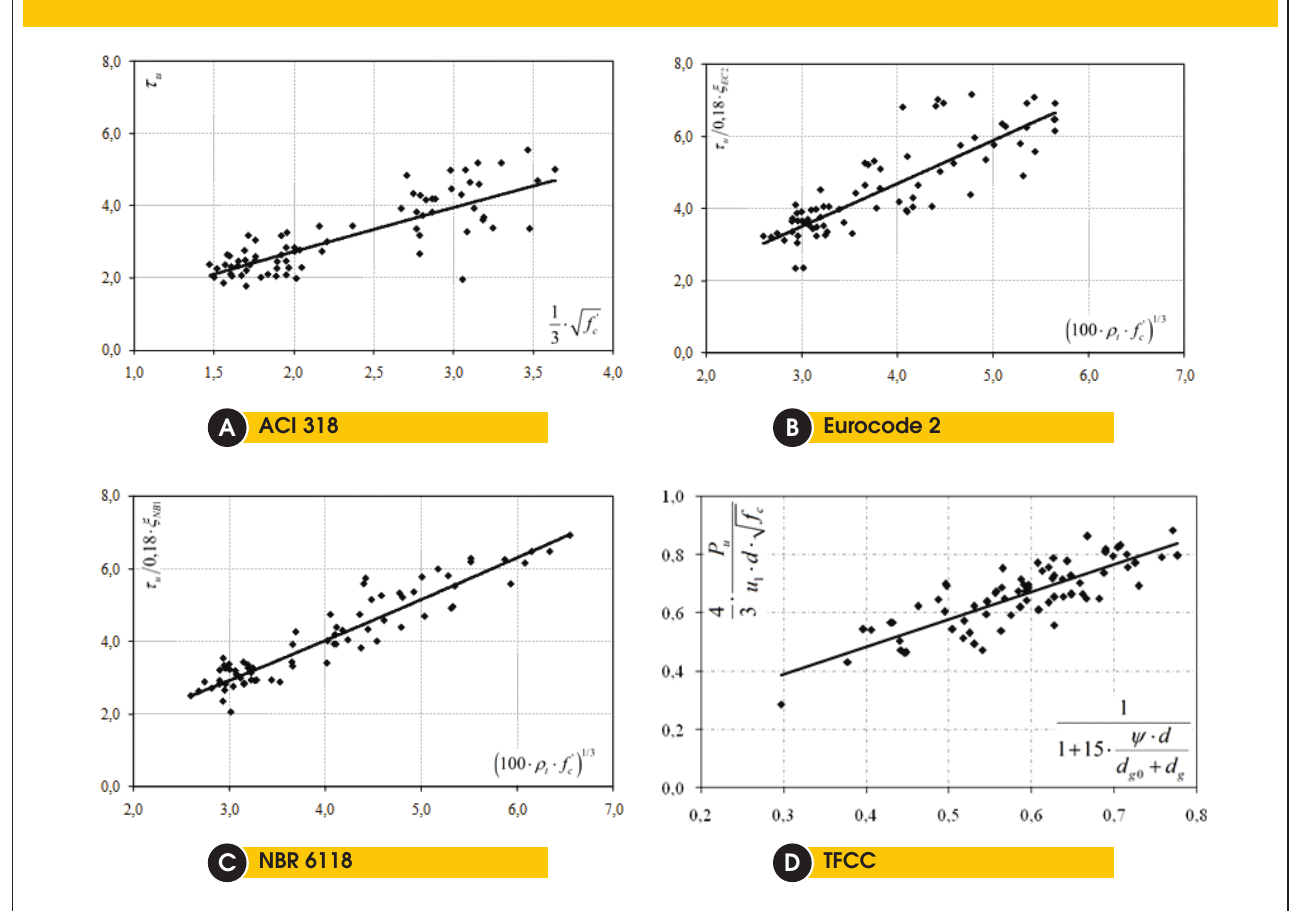
Figure 1� � Trend of results according to the different theoretical methods